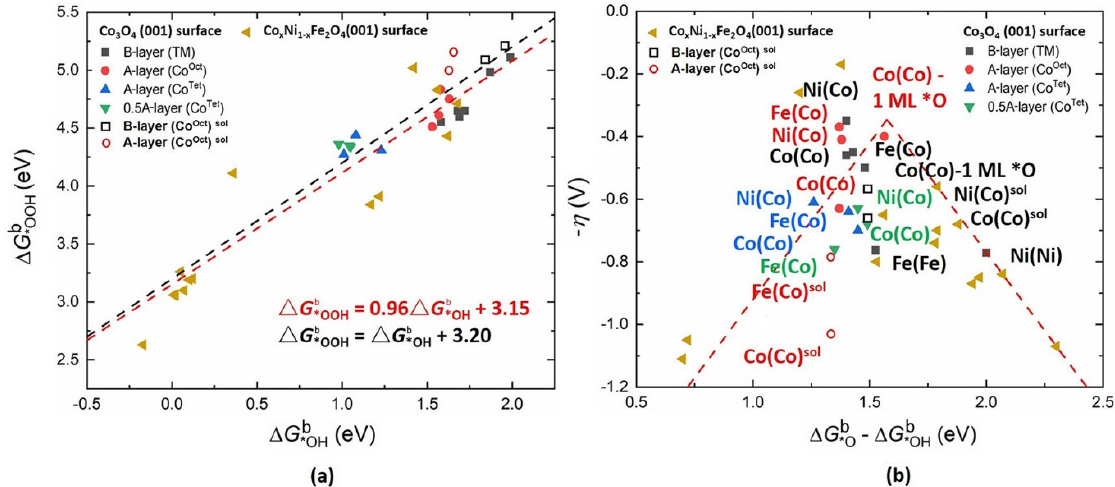
Figure 28. ( a ) Scaling relationship between Δ G *OOHb and Δ G *OHb for different reaction sites at the B-, A-, and 0.5A-terminations of the Co 3 O 4 (001) surface. Red and black dashed lines indicate the result of the linear fit and unity slope, respectively; ( b ) Volcano plot of the negative overpotential as a function of (Δ G *Ob − Δ G *OHb ). The red dashed line is calculated according to equation ( η δC = [max(( ∆ ∗ − ∆ ∗ ), 3.15 eV − ( ∆ ∗ − ∆ ∗ ))/e] − 1.23 V). The results of Co x Ni 1– x Fe 2 O 4 (001) [166] is represented by the yellow triangles using of the RPBE functional. (Reprinted from ref. [165] with permission from Journal of physical ACS Catalysis © 2021, American Chemical Society).